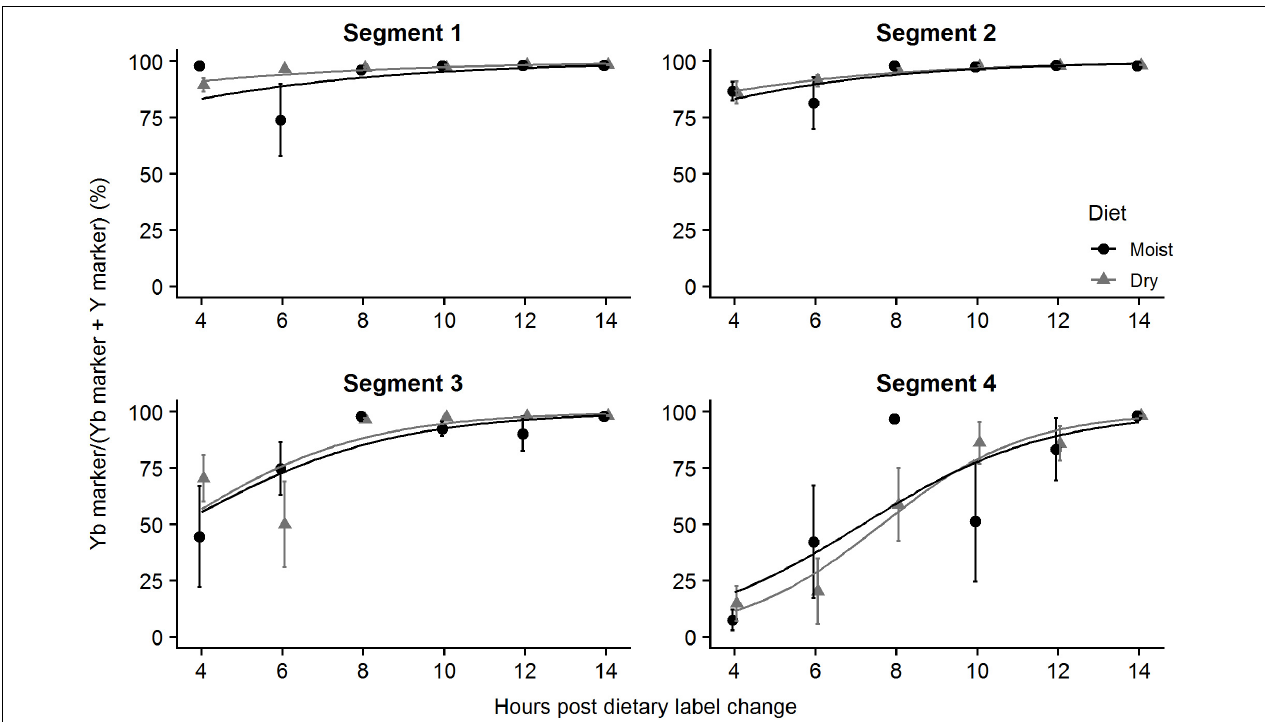
FIGURE 4 | Passage rate (% evacuation) of dry and moist diets through ballan wrasse intestine in vivo . The figures show the ratio (mean ± SEM) between Yb marker and the sum of markers [Yb × (Y 2 O 3 + Yb) − 1 × 100] represented in the gut content collected from the 4 intestinal segments ( n = 12 for each segment) at 4, 6, 8, 10, 12, and 14 h after fish fed Y-labeled feed were switched to those containing Yb. Some error bars are not visible as they are shorter than symbol heights. For each intestinal segment, no significant difference in the percentages of Yb between moist and dry diet treatments (GLMM, p > 0.05). The curves were predicted by general linear mixed models in R.